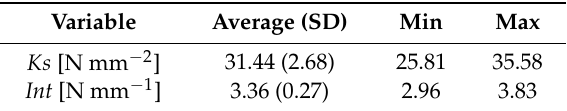
Table 3. Average specific cutting coefficient ( Ks ) and intercept values computed when machining MDF with the up-milling technique.